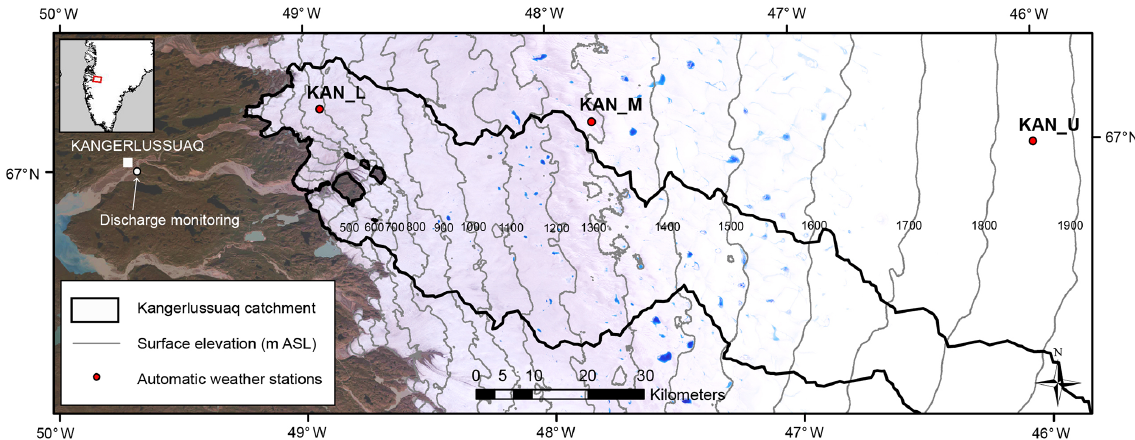
Figure 1. Map with the location of Kangerlussuaq, the monitoring site of Watson River discharge. Also plotted are the locations of the on-ice weather stations and the catchment delineation used in the calculation of ice sheet surface meltwater discharge. The inset illustrates the location of the Kangerlussuaq region in Greenland.